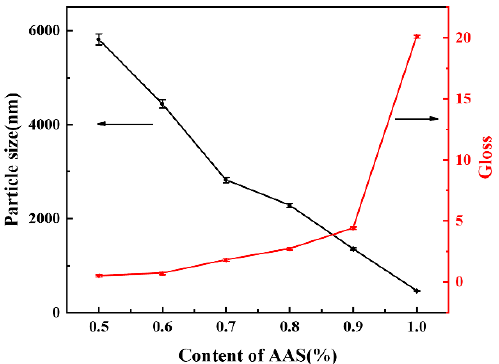
Figure 2. The particle sizes of WPU-A dispersions and gloss of WPU-A films with different AAS contents.